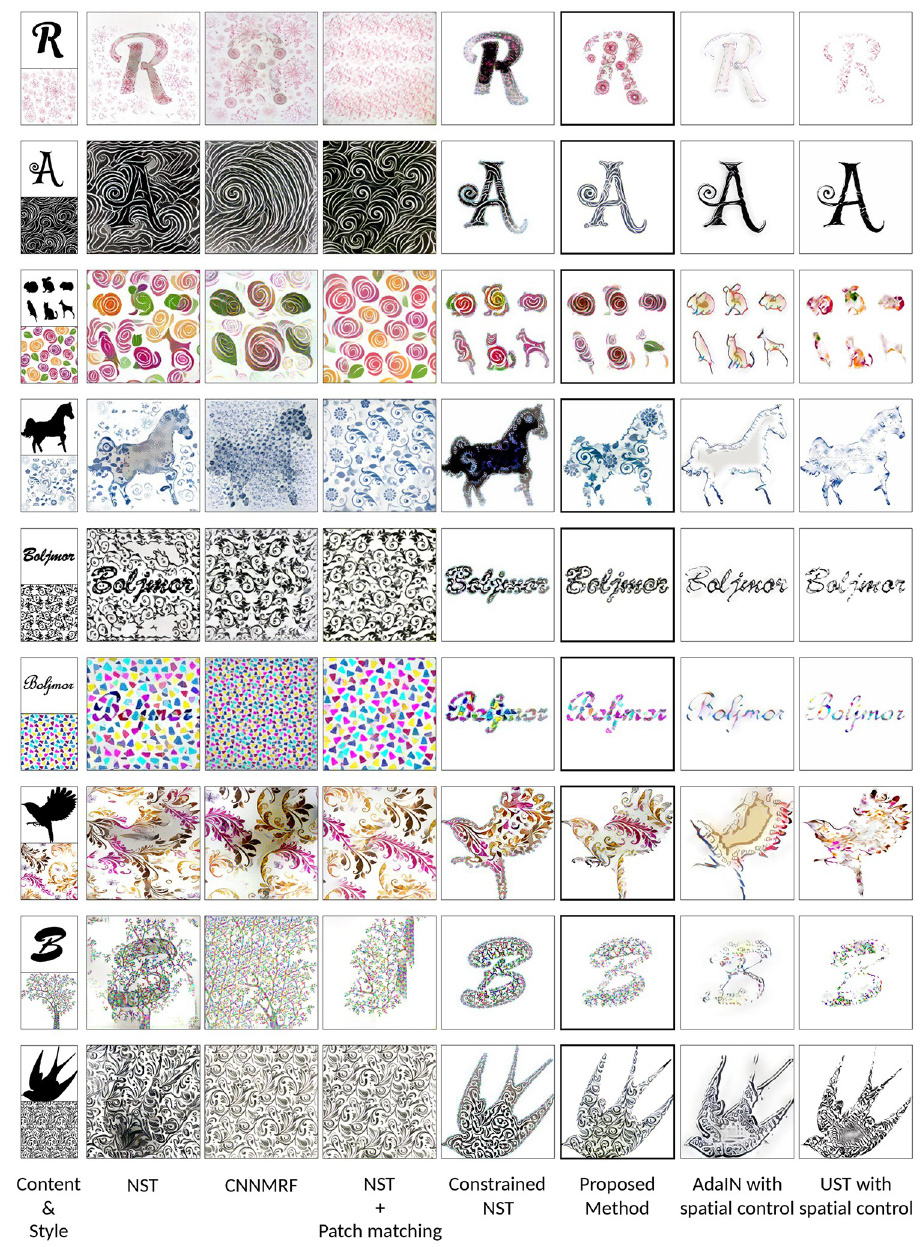
Fig 10. The results comparison with NST, CNNMRF, Constrained NST, NST + Patch matching, AdaIN with spatial control, and UST with spatial control methods. The first column shows various content and style combinations, and each column shows results from each method using the content and style combination from the